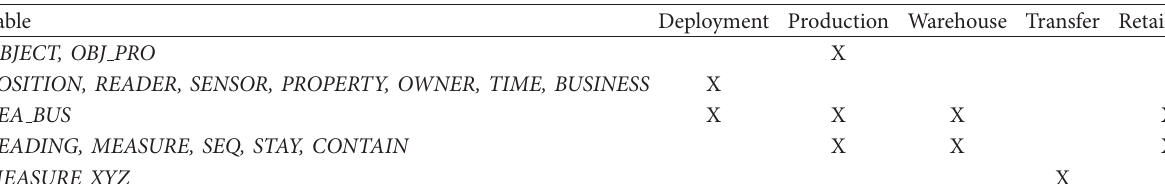
Table 4: Tables in the different stages of the supply chain.